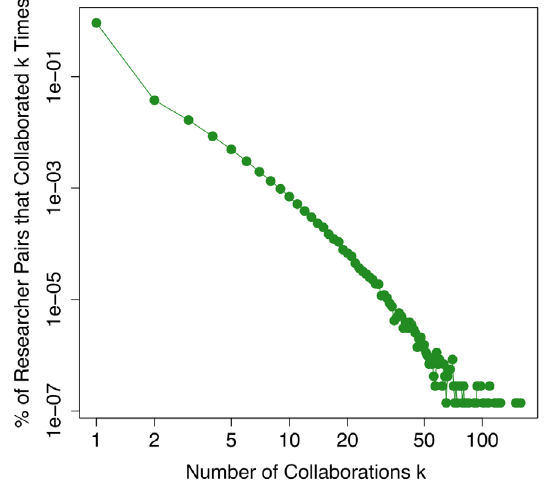
Figure 2. Collaboration frequency distribution for the Cite- Graph dataset. It is a power law distribution log ( y )= 2 3.59* log ( x ) + 0.885, where y refers to the percentage of researcher pairs that collaborate x times, with x referring to the number of